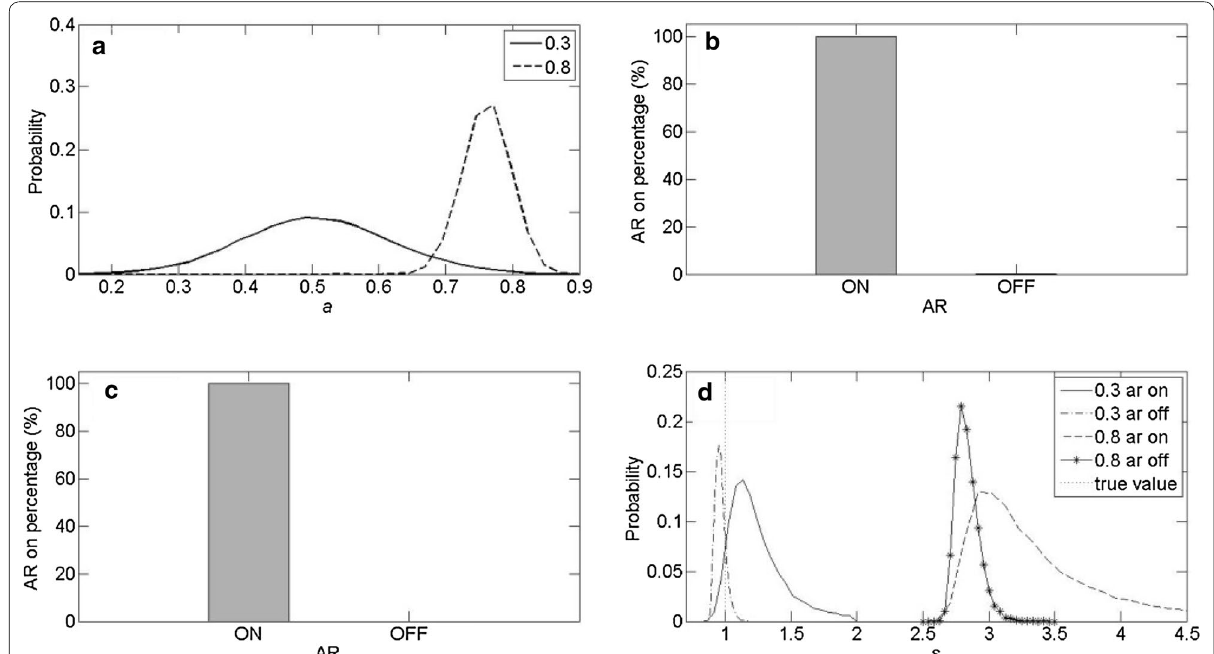
Fig. 5 Posterior error results for the eight-layer model. a , d are the 1D marginal distributions for the first-order autoregressive parameter a and error scale hyperparameter s , respectively. Solid line and dashed lines show the results for a respectively, and the dashed-dotted lines and lines with asterisks are for a a 0.3 and a 0.8, respectively. Dotted lines represent true = =